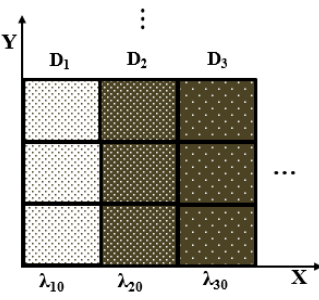
Figure 2. The arrangement of sub-eye lenses in multi-spectral ACE.